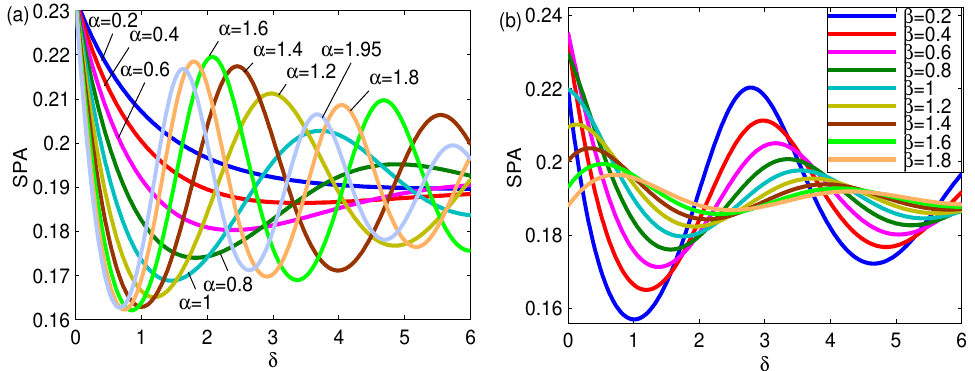
Figure 7. GSR behaviors of SPA( δ ) in (35) for distinct ( a ) α and ( b ) β . ( a ) ¯ γ = 0.1, β = 0.4, τ = 0.2, a 2 = 0.6, q = 0.3, λ = 0.6, ω 0 = 1, Ω = 2, µ = ν = 0.8; ( b ) ¯ γ = 0.1, α = 1.2, τ = 0.2, a 2 = 0.2, q = 0.3, λ = 0.6, ω 0 = 1, Ω = 2, µ = ν =